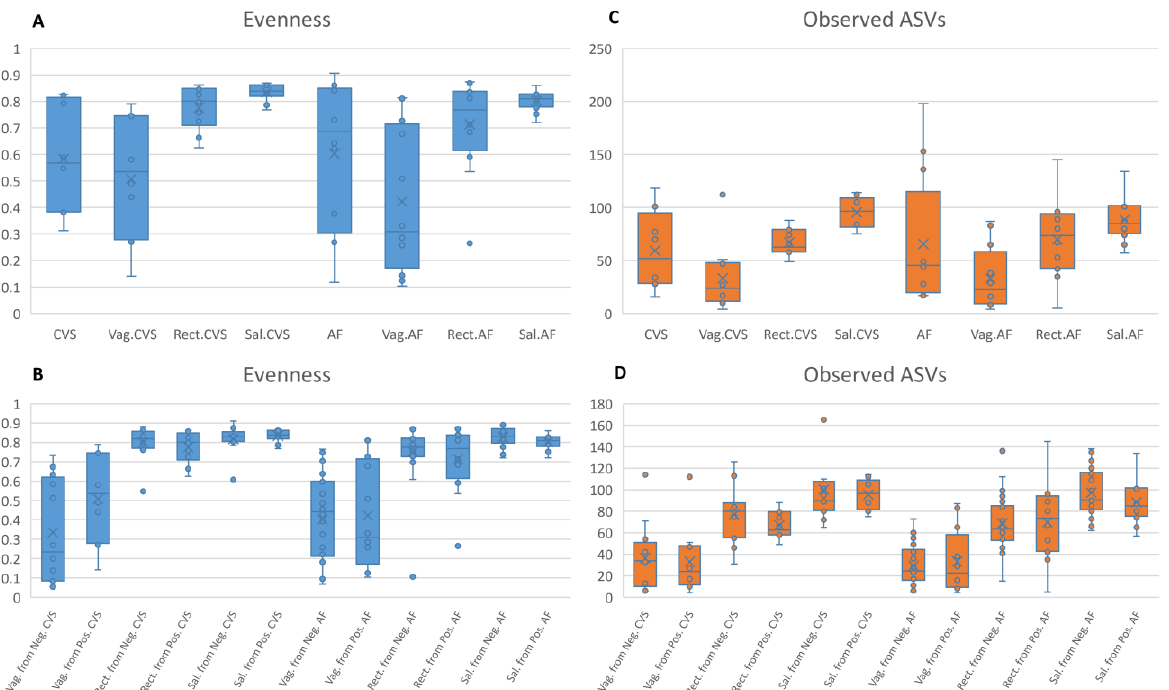
Figure 1. ( A , B ) Alpha diversity in AF and CVS samples. The alpha diversity metrics measured by means of the evenness and observed ASVs metrics. CVS = chorionic villus samples; Vag.CVS = vaginal swabs matched to CVS; Rect.CVS = rectal swabs matched to CVS samples; Sal.CVS = saliva samples matched to CVS; AF = amniotic fluid samples; Vag.AF = vaginal swabs matched to AF; Rect.AF = rectal swabs matched to AF samples; Sal.AF = saliva samples matched to AF. The comparisons among groups were performed by the Kruskal – Wallis test. ( C , D ) Alpha diversity in different body sites. The alpha diversity metrics measured by means of the evenness and observed ASVs metrics. The comparisons among groups were performed by the Kruskal – Wallis test.